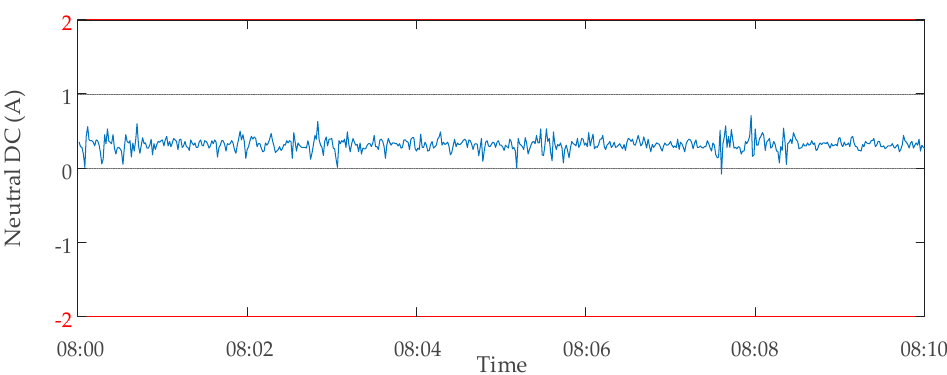
Figure 13. Monitoring data of neutral DC of transformer D on 30 October 2019. Sensors 2020 , 20 , x FOR PEER REVIEW